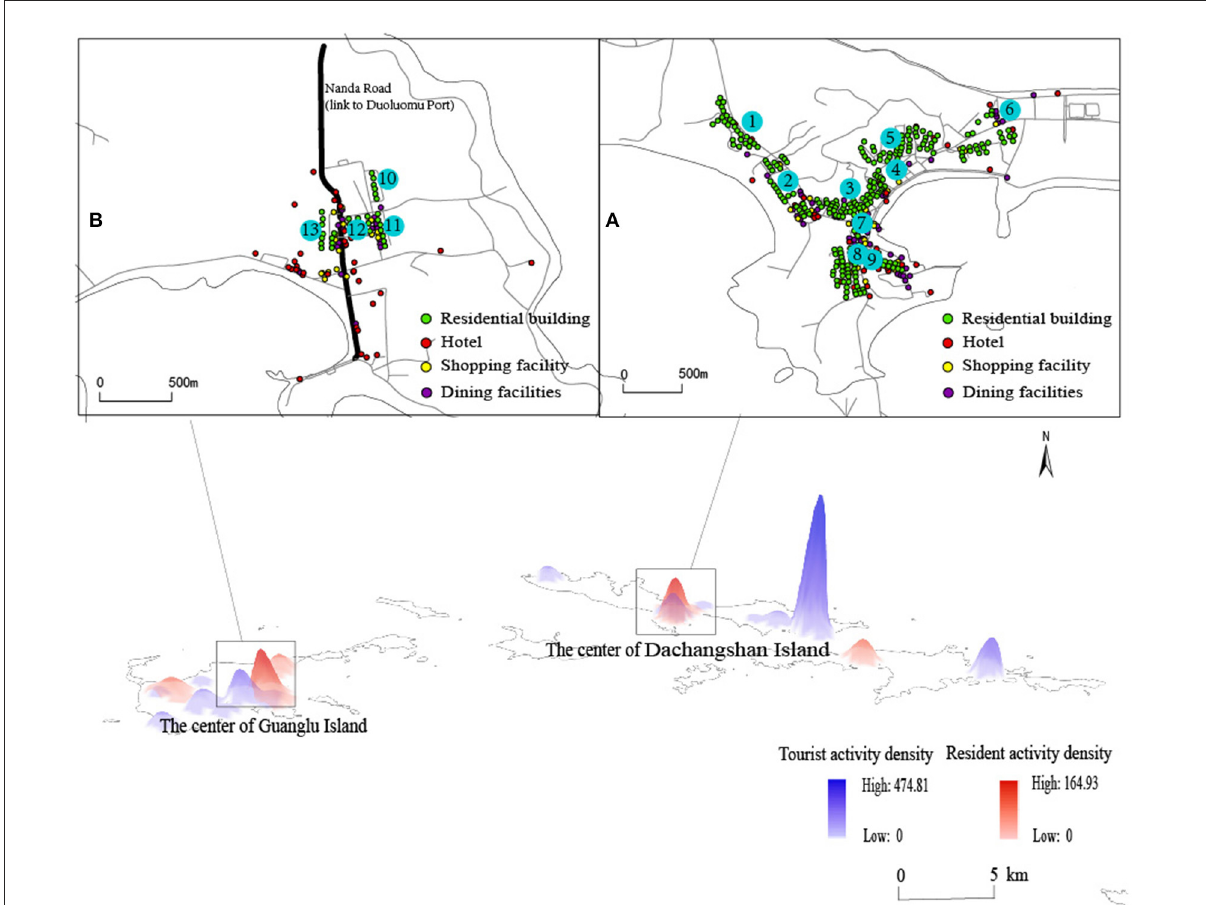
FIGURE1 Location of the study area. (A) The center of the Dachangshan island. (B) The center of the Guanglu island. The numbers 1-13 represent the mainly places in the study